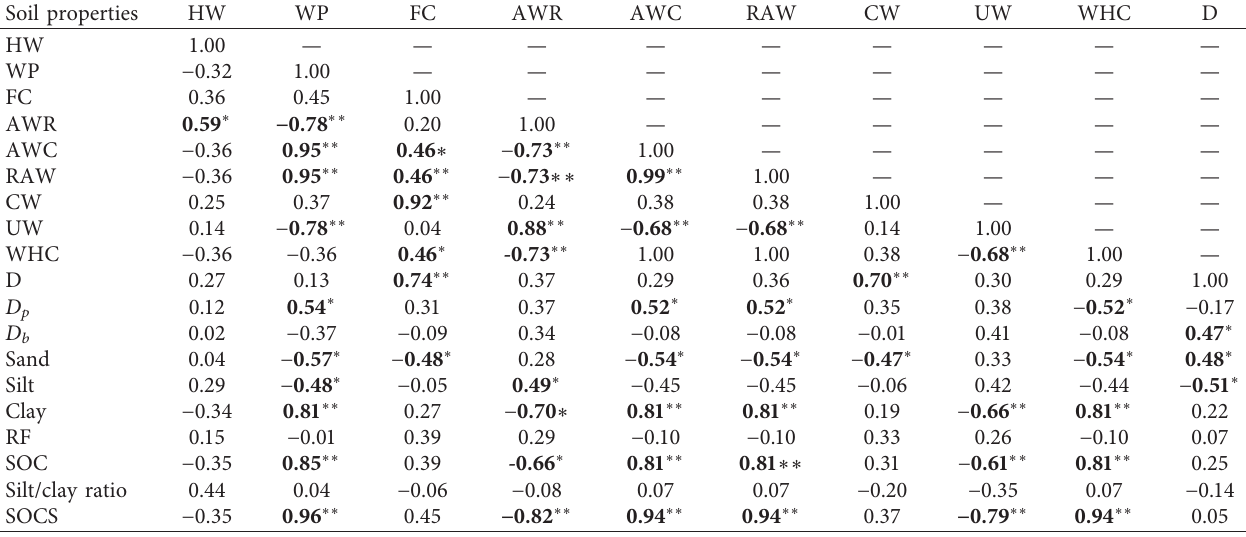
Table 6: Pearson linear correlation coefficients amongst soil moisture characteristics ( n � 20).